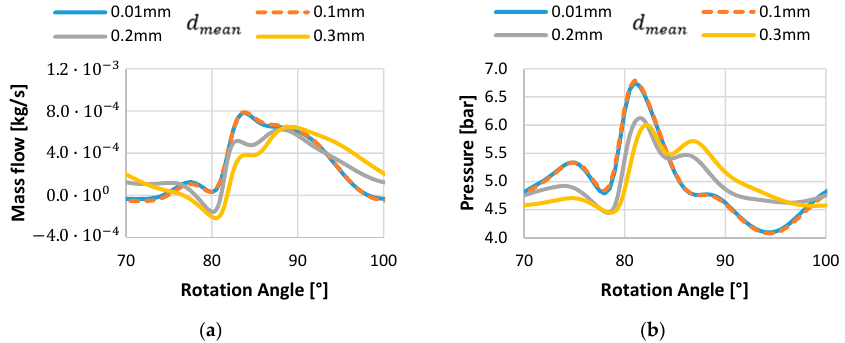
Figure 24. Influence of the mean bubble diameter d mean on the ( a ) outlet 1 mass flow rate and ( b ) outlet 1 pressure ripple at 5-bar delivery pressure and 2000 rpm.